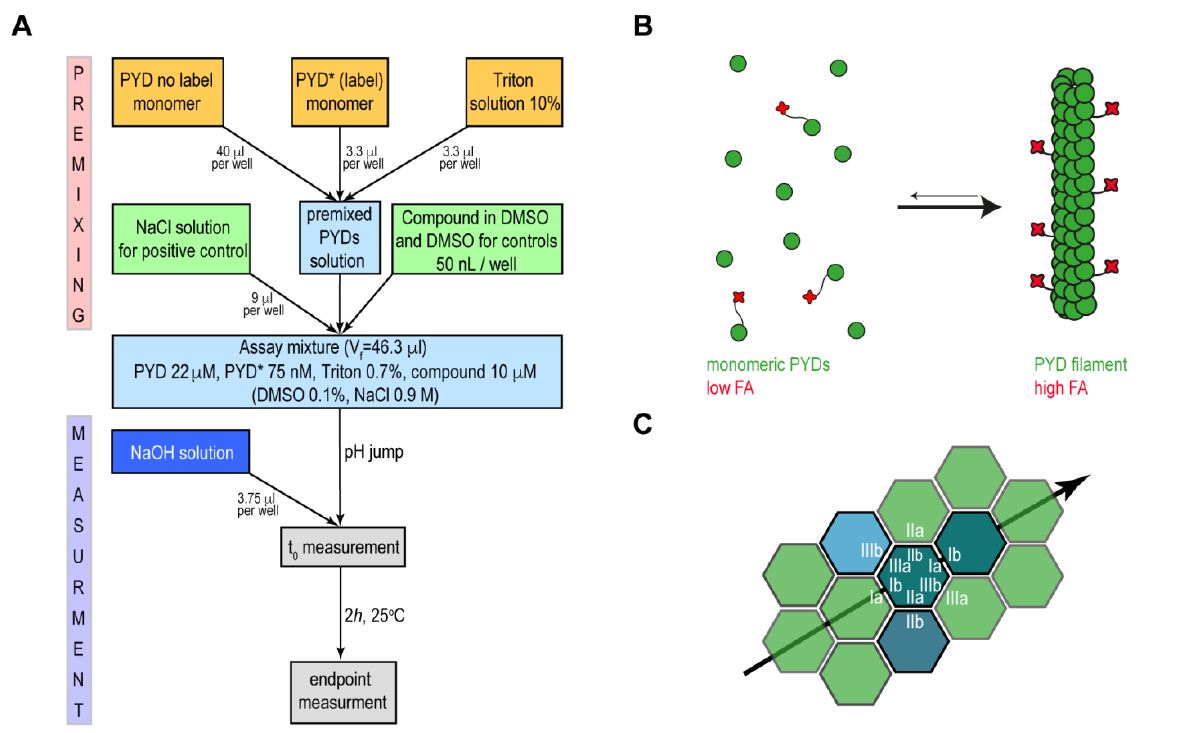
FIGURE 1: Principle of the high-throughput fluorescence anisotropy assay. (A) Flowchart of the assay procedure for the high-throughput screening. The initial PYD solution shown in light blue is prepared by mixing the specified volume amounts from 25 µM and 1 µM stock solutions of not labelled PYD and Fluorophore-labelled PYD (PYD*) respectively and 10% Triton solution, yellow rectangles. In the premixed solution labelled and unlabelled PYD are maintained in a soluble and monomeric forms by low pH condition. The addition to premixed PYD solutions of either NaCl as positive control or DMSO solution with and without the compounds are identified by the green rectangles. The resulting assay mixture is highlighted in light blue. The jump from acidic to physiological pH condition is achieved by addition of a fixed volume amount of a 60 mM NaOH solution to the assay mixture, highlighted by the dark blue rectangle. Fluorescence anisotropy is moni- tored as a single point measurement after incubation for 2 h at 25 ° C and filament formation is evaluated as the difference between fluo- rescence anisotropy at the initial and endpoint of the measurement, grey rectangles. (B) Scheme of the ASC filament formation during the fluorescence anisotropy (FA) assay. Monomeric PYD domain of ASC protein (green) and PYD* labelled with Alexa Dylight 488 fluorophore (red). The pH shift-induced filament formation leads to the anisotropy increases. (C) A schematic 2D diagram of the PYD filament arrange- ment where individual monomeric PYD domains required for filament formation are coloured in dark green, teal and light blue over the filament scaffold reported in light green. The asymmetric interfaces type I, II and III as observed on the human (PDB 3J63) and mouse (PDB 2N1F) PYD filament structures are labelled in white. The black arrow highlights the directionality of filament propagation within a single layer through the interactions between the interfaces type Ia and